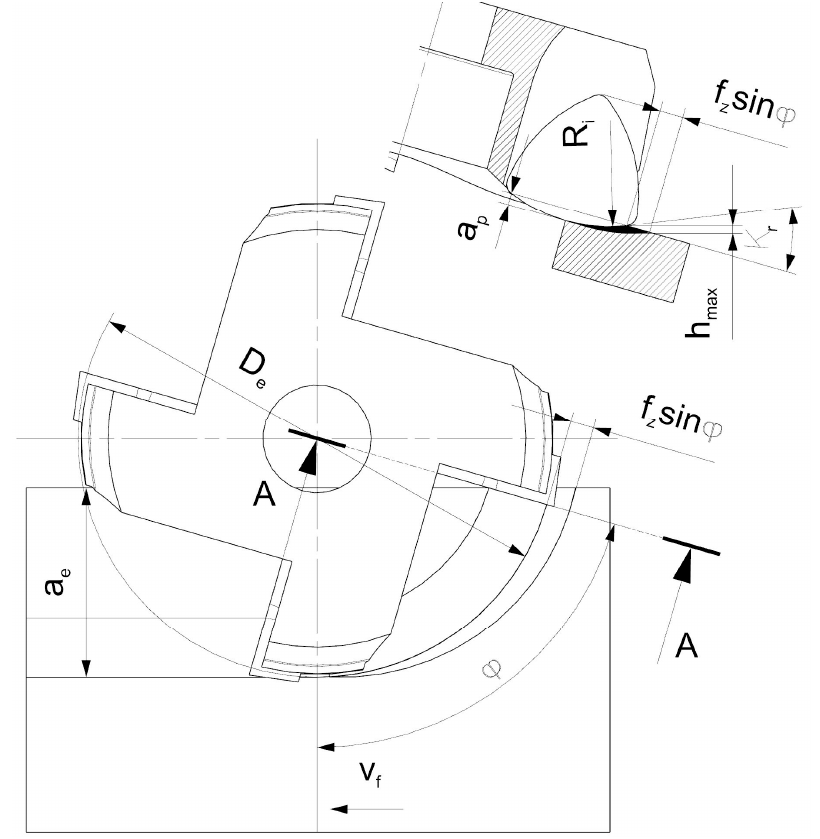
Figure 2. The essence of